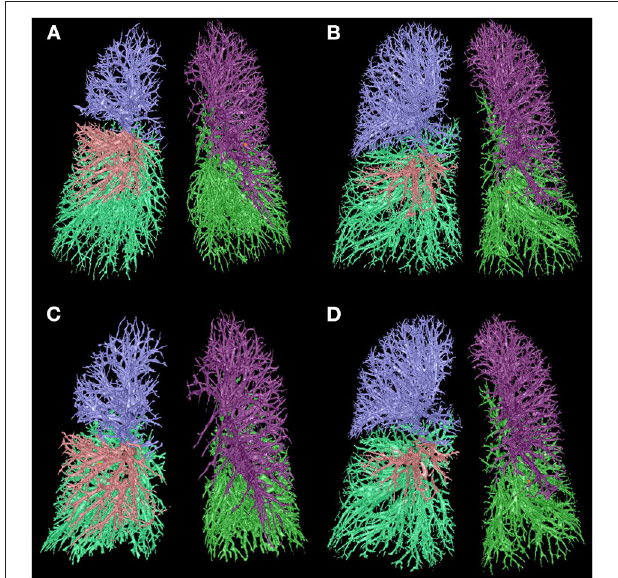
FIGURE 2 | Comparison of IPVV between mild and severe COPD in inspiratory and expiratory CT. (A,C) A male with mild COPD (GOLD II, 68 years): a, the IPVV of the whole lung in inspiratory CT is 209.95ml; b, the IPVV of the whole lung in expiratory CT is 169.10ml. (B,D) A male with severe COPD (GOLD III, 64 years): a, the IPVV of the whole lung in inspiratory CT is 208.31ml; b, the IPVV of the whole lung in expiratory CT is